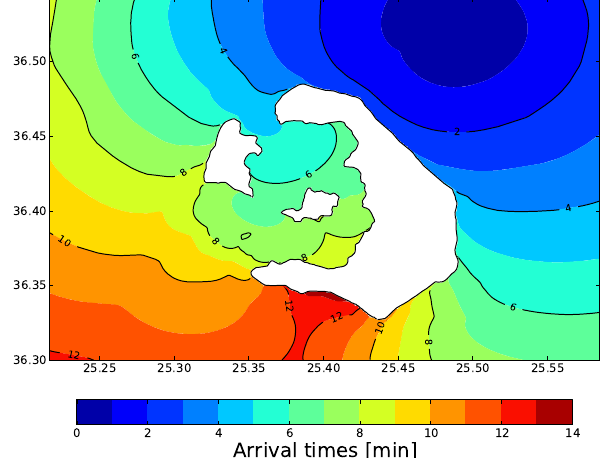
Fig. 7. First wave arrival times for Santorini island and its surround- ings. Black lines are drown with an interval of 2min. Results are for simulation with η 0 = 50m and no bottom friction.